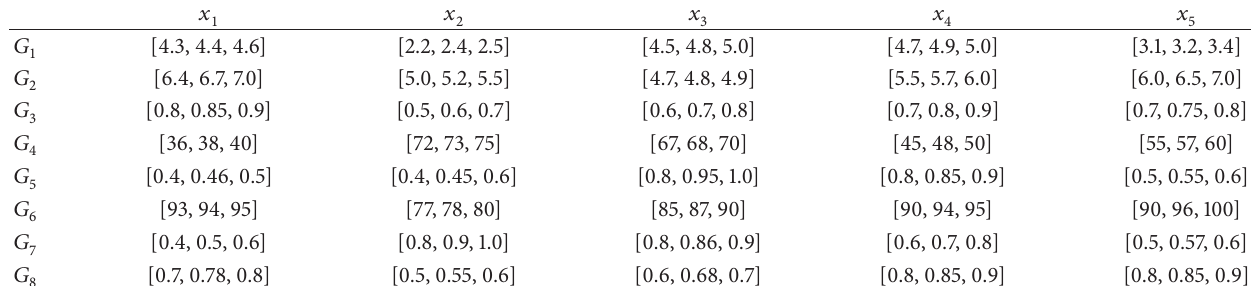
Table 3: Triangular fuzzy number decision matrix 𝐴 (3)